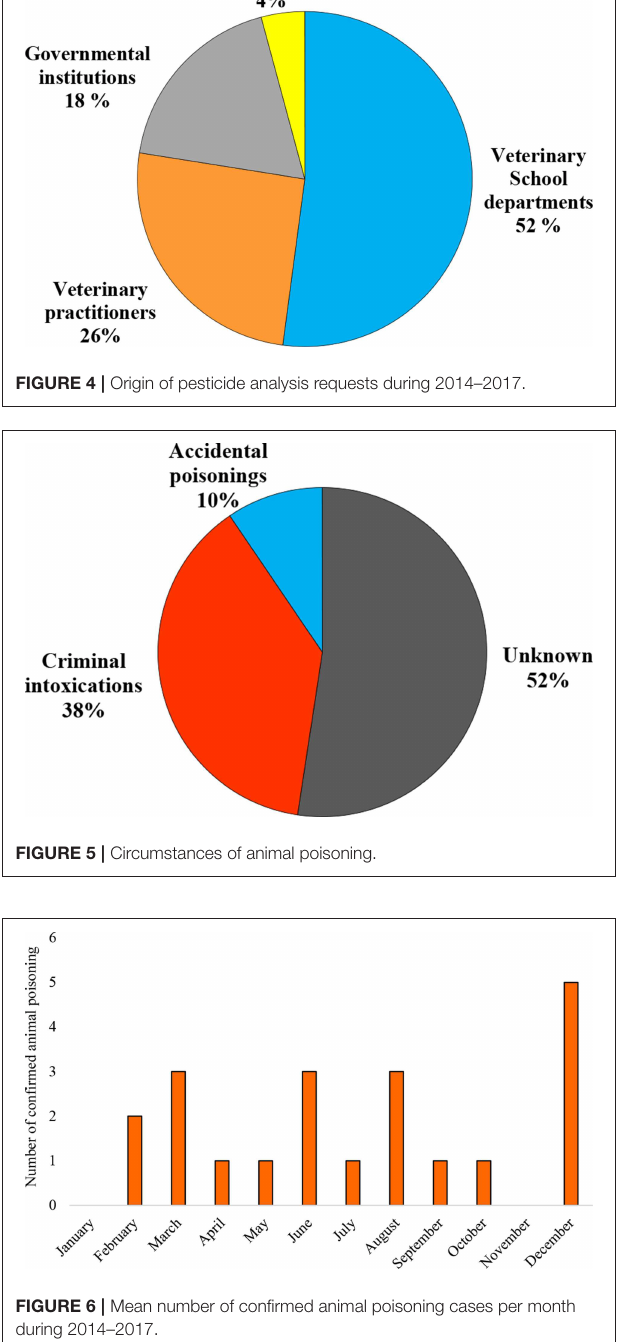
Accidental poisoning was even due to the misuse of pesticides were stored improperly).